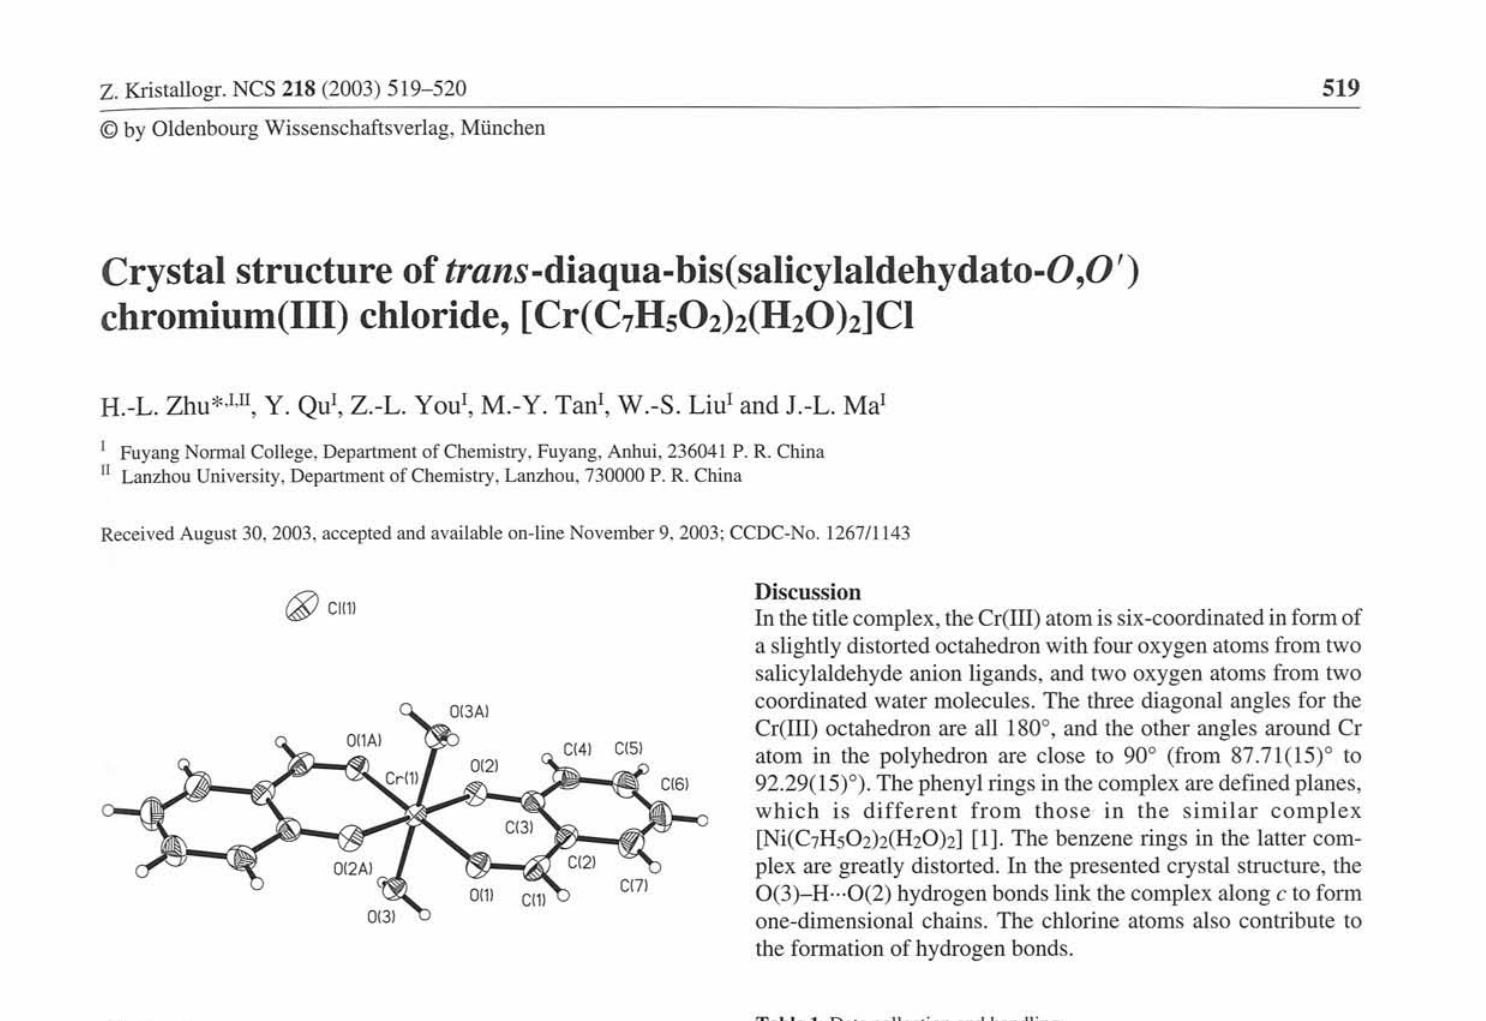
Table 1. Data collection and handling.